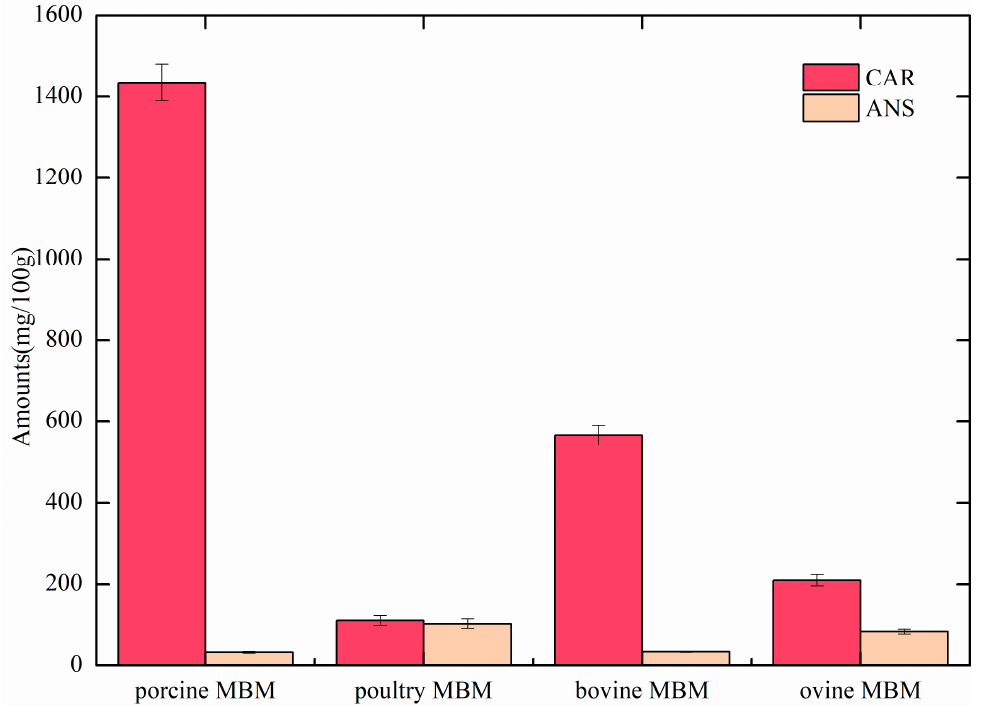
Figure 3. The amounts of carnosine (CAR) and anserine (ANS) in four types of MBM samples (porcine, poultry, bovine, and ovine origins)